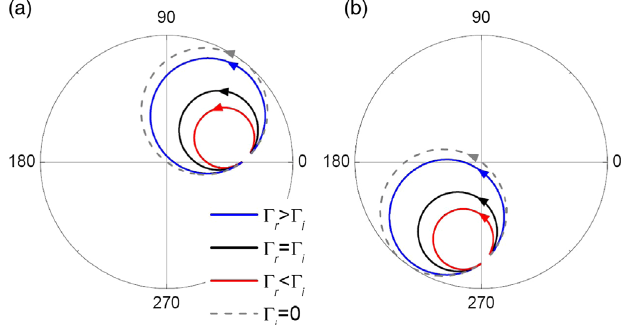
FIG. 13. CMT analysis of a two-port, single-mode resonator. (a),(b) Smith curves for r and t according to Eq. (C2), respec- ¼ 0 . 05 f tively. Four representative cases are plotted: Γ 0 and i Γ ¼ 0 . 1 f Γ ¼ 0 . 1 f Γ ¼ 0 . 1 f 0 (blue curve), 0 and 0 (black r i r ¼ 0 . 15 f Γ ¼ 0 . 1 f Γ ¼ 0 curve), Γ 0 and 0 (red curve), and i r i ¼ 0 . 1 f and Γ 0 (gray curve). Without loss of generality, the r reflection and transmission coefficients of the background medium are set as r 0 ¼ 0 . 6 and t 0 ¼ − 0 . 8 i